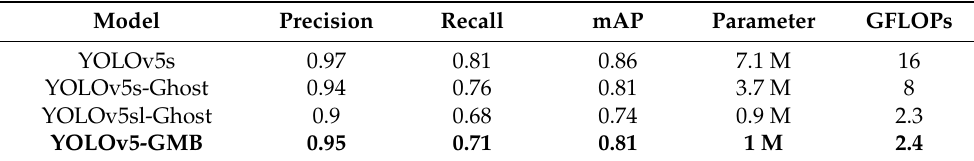
Table 1. Experimental data indicators of YOLOv5-GMB and other detection algorithms.